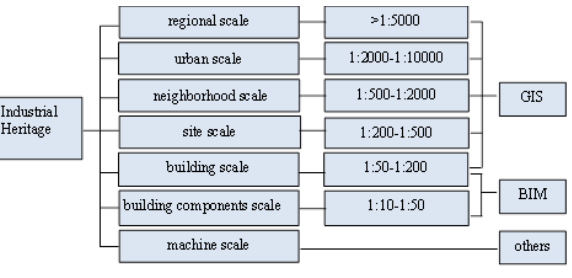
Figure 3. Spatial scale of an industrial heritage and corresponding technologies